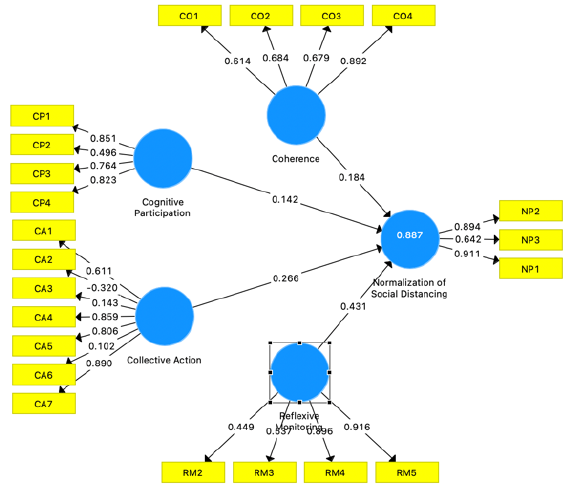
Figure A3. Model Generated on the Second Iteration after Removing Multicollinearity (Removing RM1).